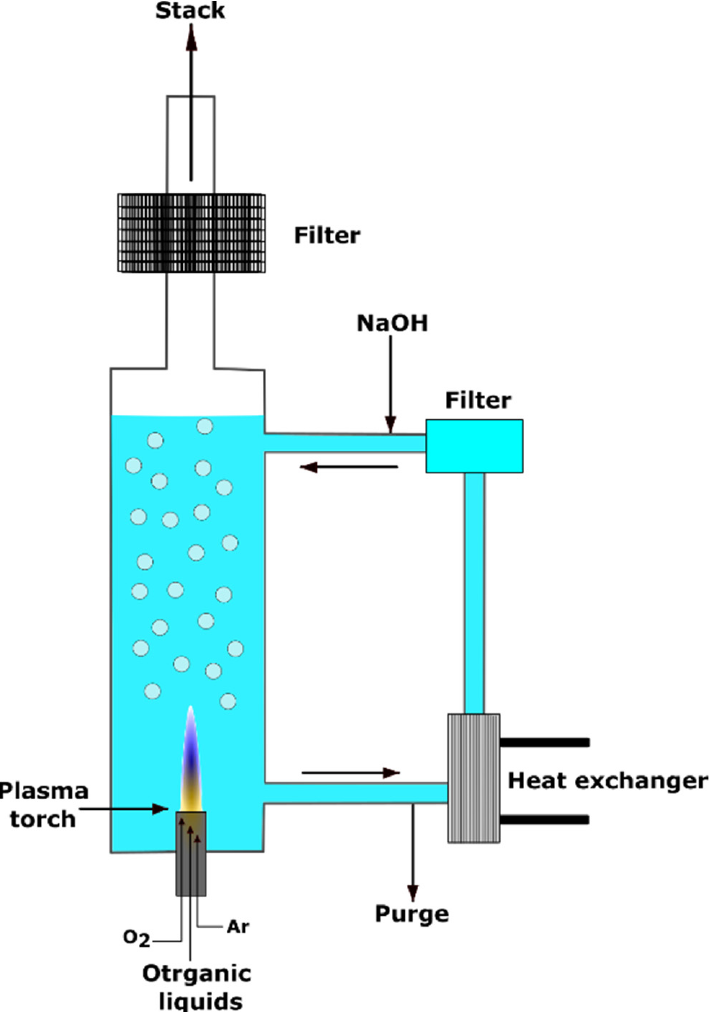
Figure 9. Atmospheric plasma torch employed for the destruction of organic pollutions in